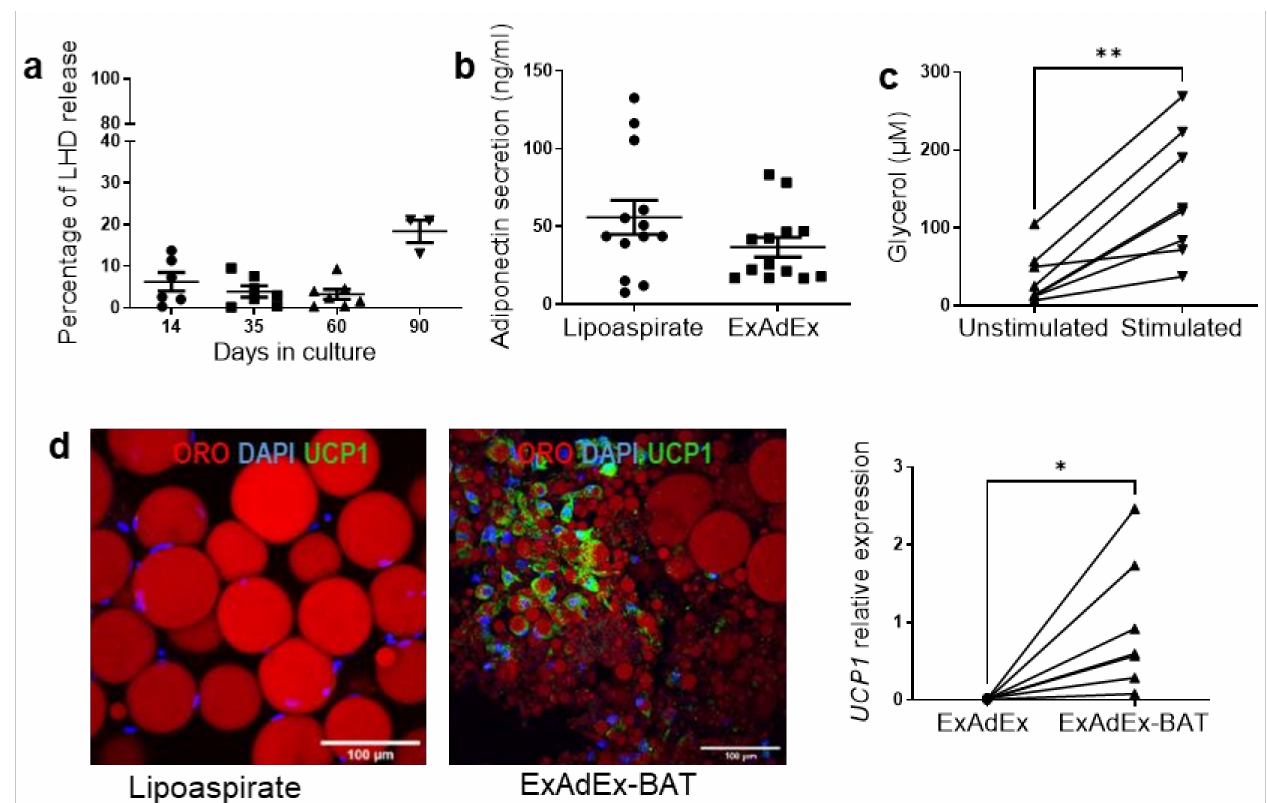
Figure 3. Long-term viability and functionality. ( a ) Levels of LDH activity released in the culture medium were determined after the indicated times in culture. Data are presented as a percentage of the LHD activity of the triton-lysed tissue, measuring the maximum released; n = 7 donors. ( b ) Long- term functionality. Levels of adiponectin secreted in 24 h by 100 mg of lipoaspirate and the derived ExAdEx product maintained in vitro for 60 days; n = 13 donors. ( c ) Lipo-lytic capacity. One mg of ExAdEx encapsulated was maintained in vitro for 21 days, and then the glycerol release was measured 24 h after stimulation with 1 µ M isoproterenol; n = 7 donors. Similar data were obtained after maintenance 60 days in culture. ( d ) Beiging potential. The ExAdEx products were maintained in vitro for 30 days and then were induced to undergo beiging as described in the Methods section. After two weeks, UCP1 was revealed by immunofluorescence (left panel, scale bar: 100 µ m) and by gene expression compared to the lipoaspirate (right panel). Data are expressed as a fold increase compared to UCP1 expression in lipoaspirates; n = 7 donors. * p ≤ 0.05, ** p ≤ 0.01 using